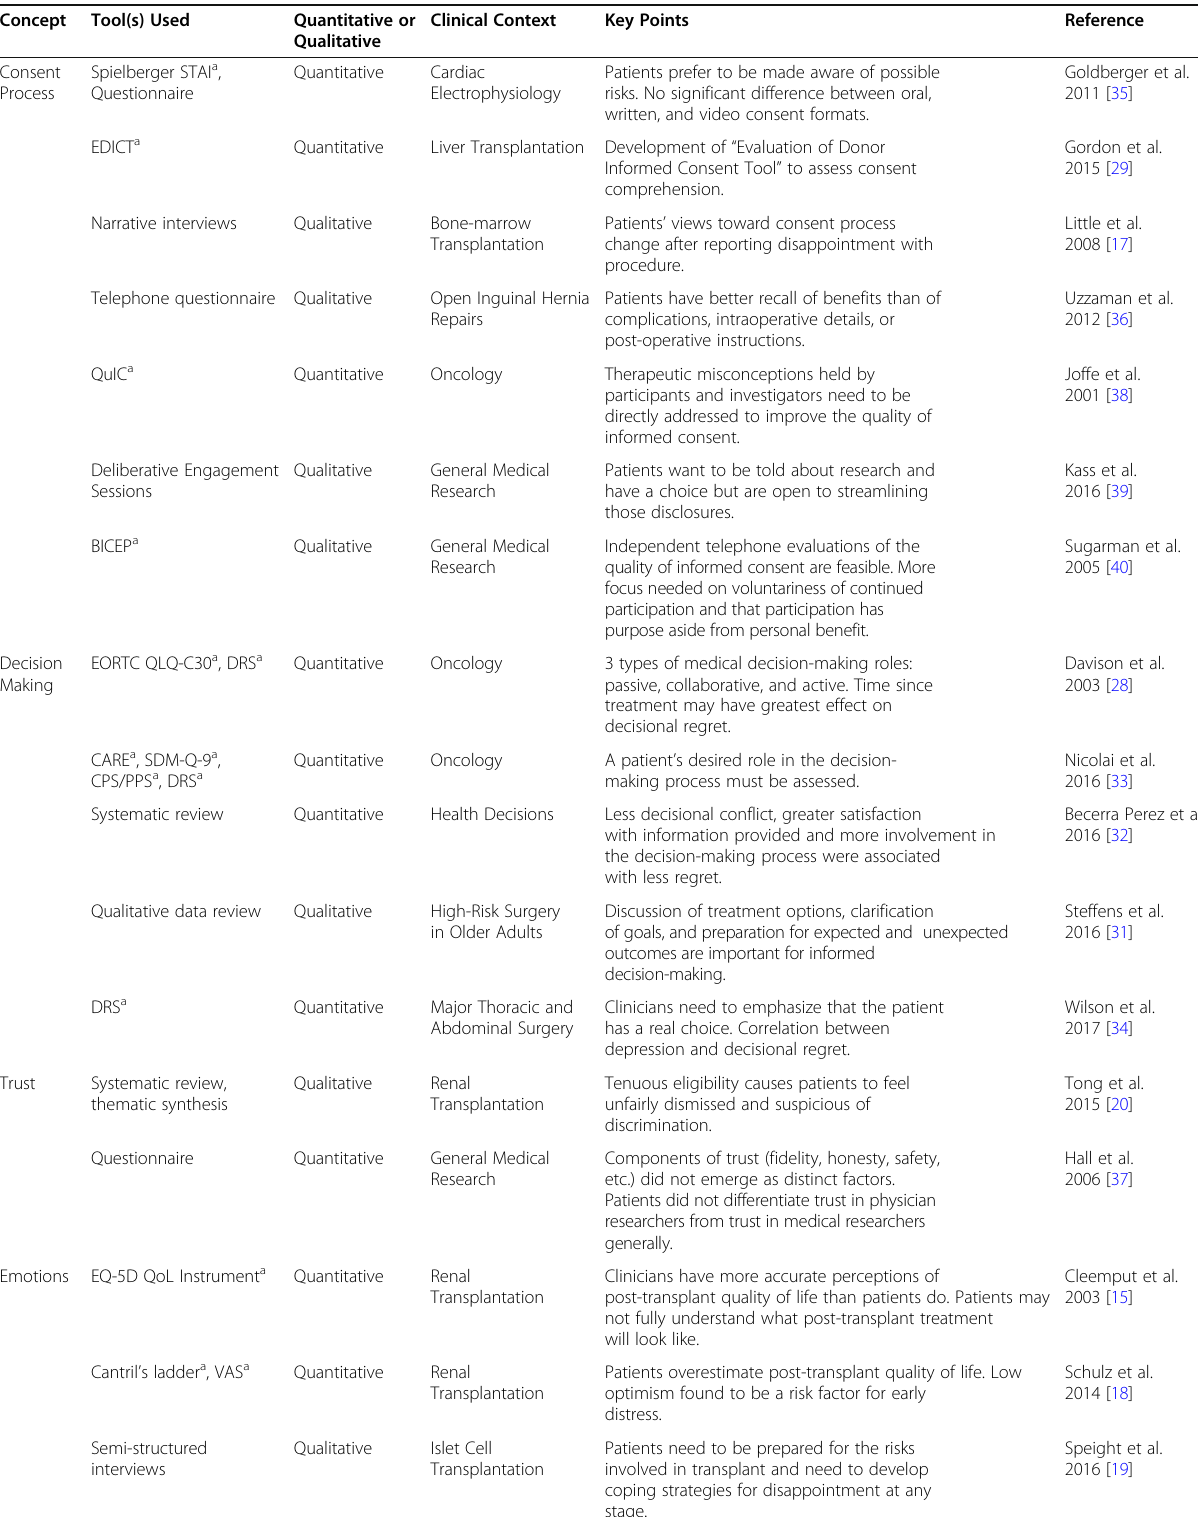
Table 1 PROMETHEUS literature review summary Concept Tool(s)